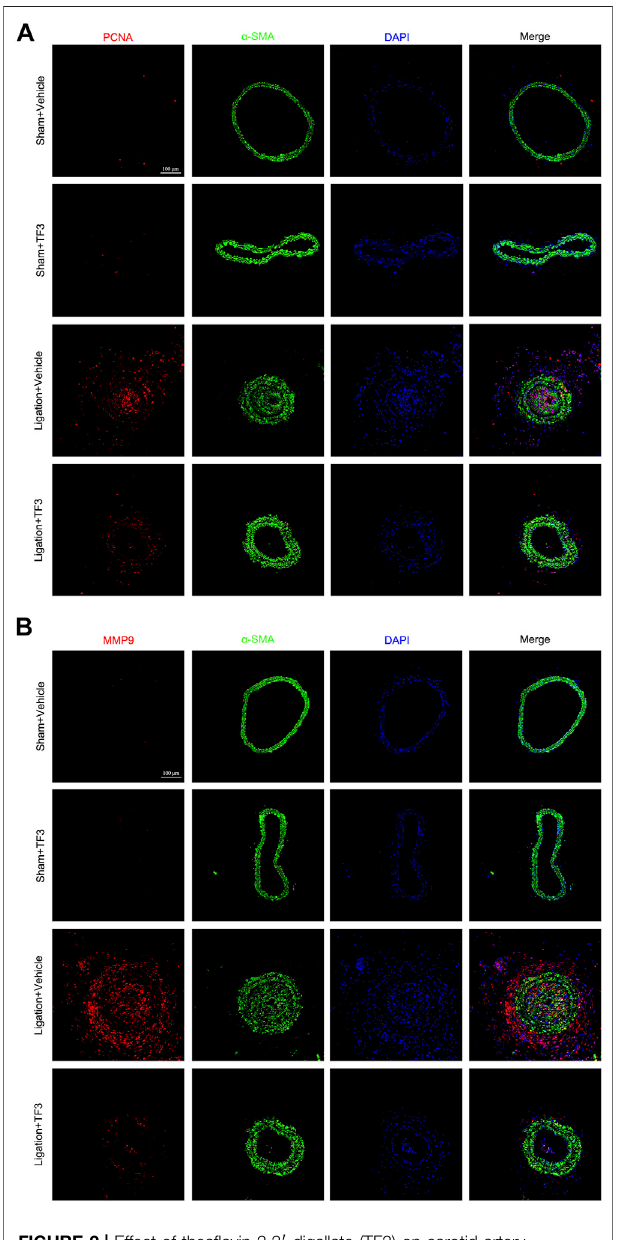
FIGURE 2 | Effect of thea fl avin-3,3 ′ -digallate (TF3) on carotid artery ligation – induced neointimal hyperplasia. TF3 (10 mg/kg) or vehicle was intraperitoneally injected after carotid artery ligation. (A) Immuno fl uorescence staining of PCNA (red), α -SMA (green), and DAPI (blue) are shown. (B) Immuno fl uorescence staining of MMP9 (red), α -SMA (green), and DAPI (blue) are shown. Scale bar, 100 μ m.